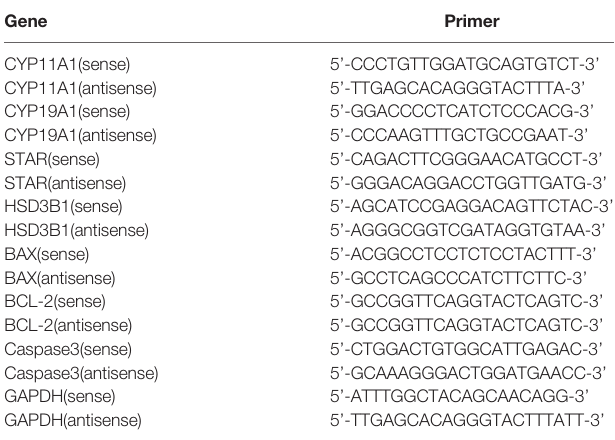
TABLE 2 | The primer sequences for CYP11A1, CYP19A1, STAR, HSD3B1, BAX, BCL2, Caspase3 and GAPDH. Gene Primer